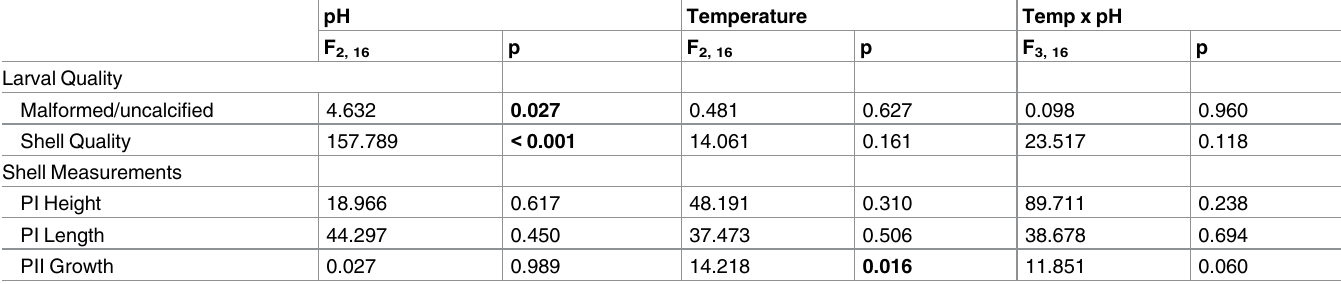
Table 2. Summarytable of 2-way ANOVA.